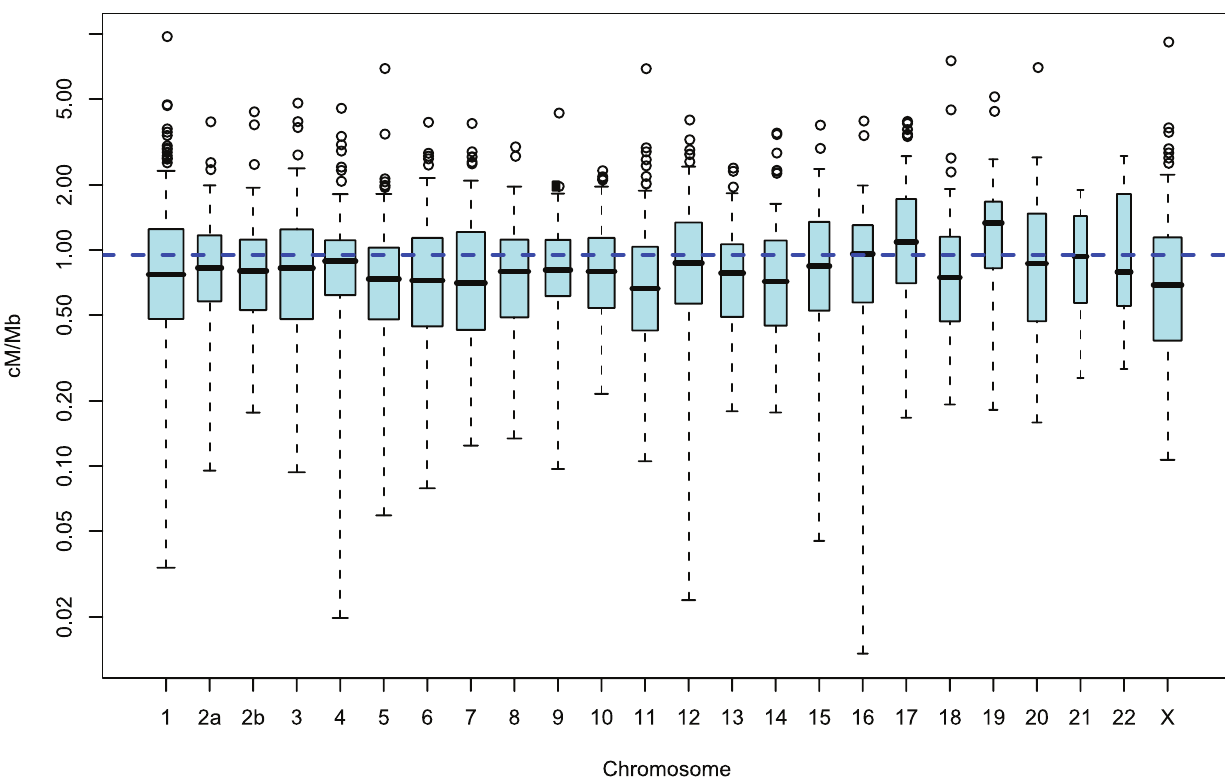
Figure 11. Distribution of recombination rate estimates for each chromosome. The box plot shows the distribution of the estimated recombination rate for each chromosome. The dashed line shows the genome-wide average.